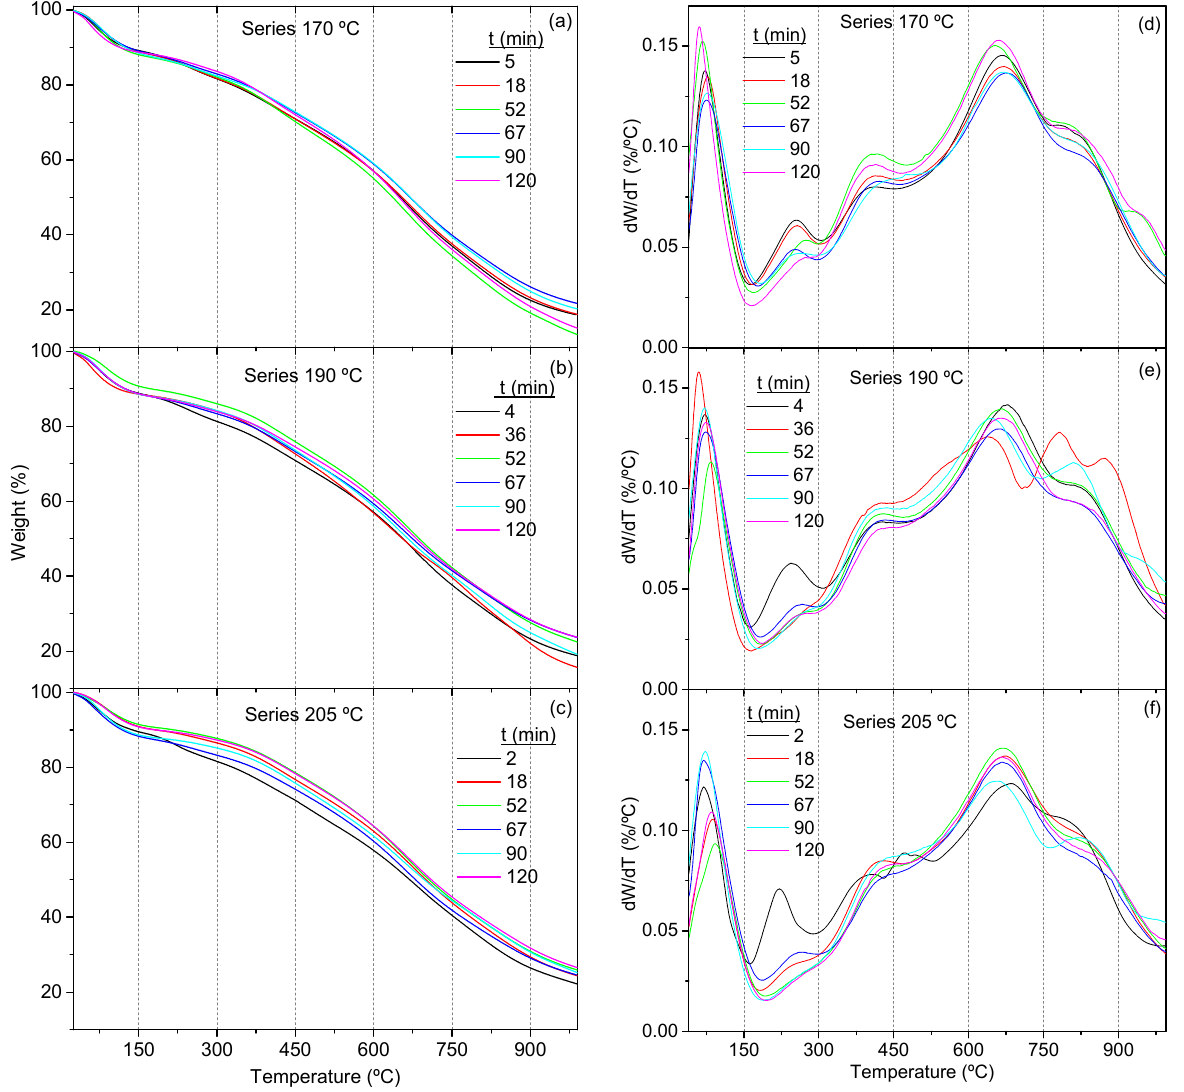
Figure 7. ( a – c ) Representative TG curves for NH 4 CN polymers synthesized at different temperatures and reaction times as indicated in the legends of the figure; ( d – f ) DTG curves corresponding to the TG curves.